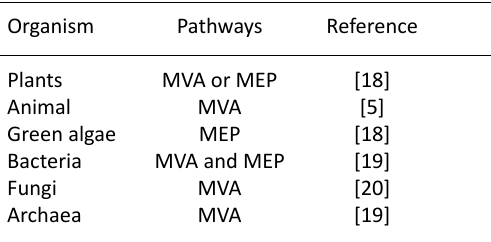
Table 1. Pathways for the biosynthesis of terpenoids present in a different organism.